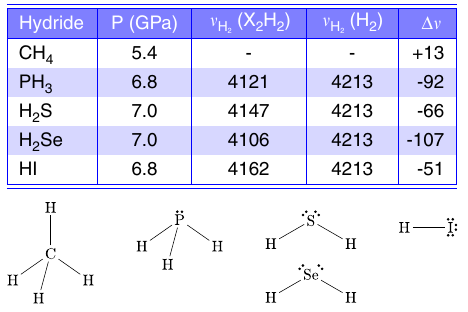
Fig. 6 Raman shift of the H 2 stretching vibration in different isostructural X 2 H 2 compounds. Upper panel. Table reporting the Raman frequency (cm − 1 ) of the H – H stretching vibration of H 2 molecules in different isostructural X 2 H 2 crystals ( ν H (X 2 H 2 ) with X = CH 4 19 , PH 3 , H 2 S 26 , H 2 Se 27 , and HI 57 ) and their 2 frequency shift ( Δν ) with respect to bulk H 2 ( ν H (H 2 )) in comparable pressure 2 conditions. Ref. 19 directly provides the frequency shift value for CH 4 . Lower panel. The molecular structures of CH 4 , PH 3 , H 2 S, H 2 Se, and HI, drawn according to the VSEPR theory and ful fi lling the octet rule for the electron outer shell, are shown to highlight the absence of lone pairs on C in CH 4 , comparing to the other hydride forming